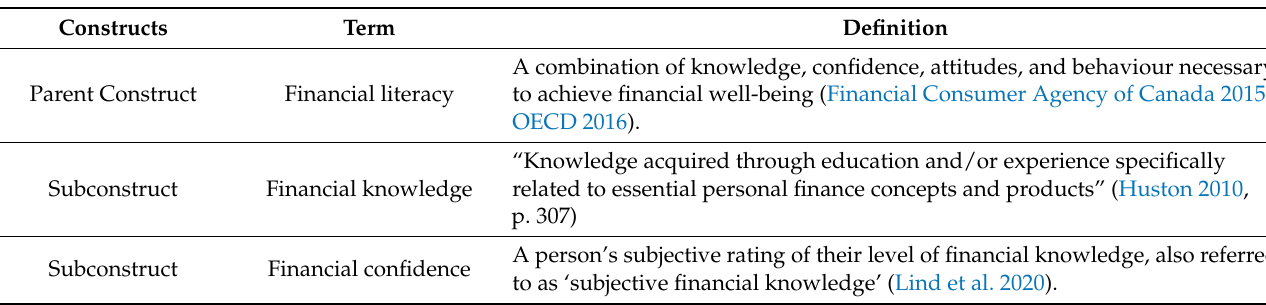
Table A1. Terminology and Definitions of Key